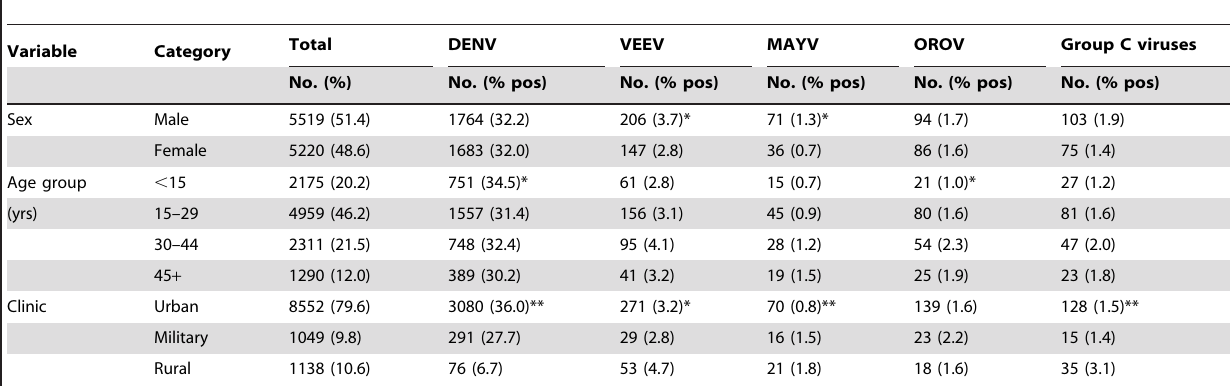
Table 7. Association between arbovirus infection and demographic variables in Iquitos, Peru, 2000–2007.